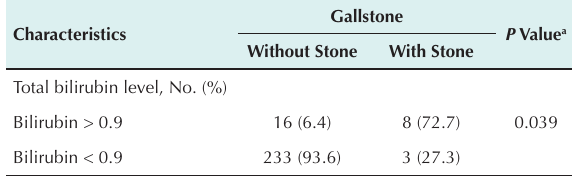
Table 6. Gallstone Frequency and Bilirubin Level in Celiac Patients